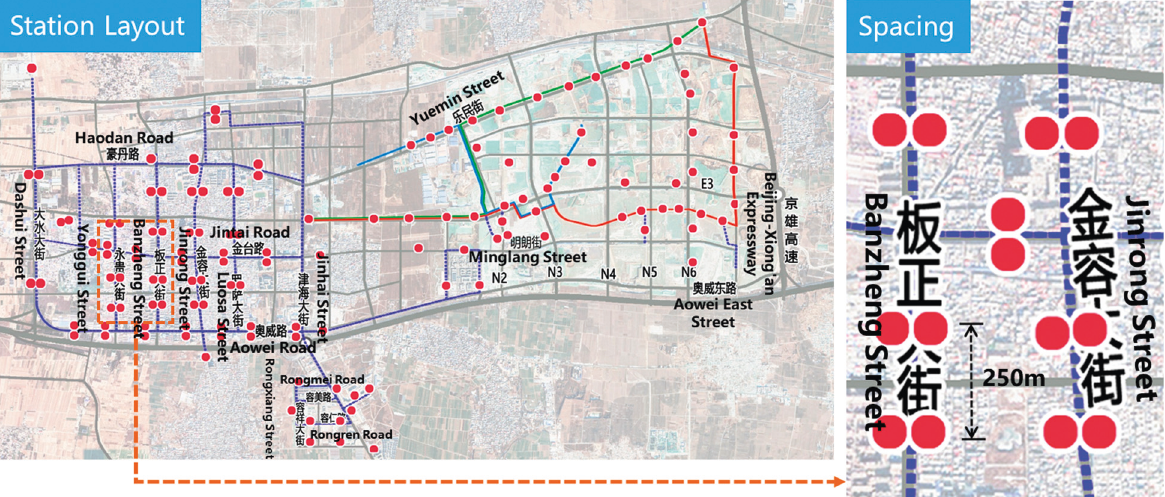
Figure 8: Station layout of Xiong’an bus sharing